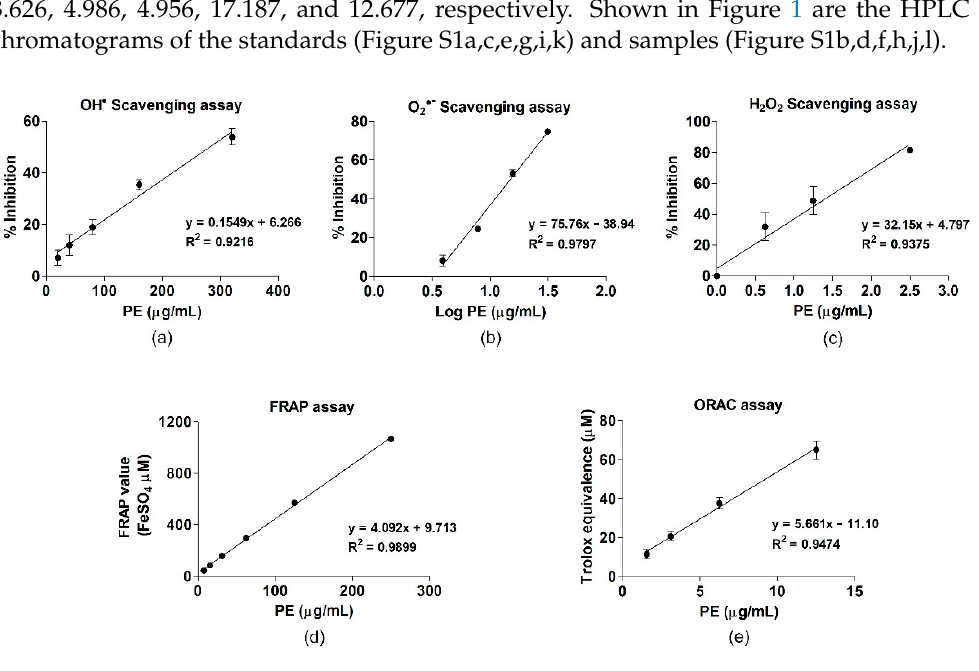
Figure 1. The linear regression of specific reactive oxygen species (ROS)-scavenging activities and antioxidant capacities of PE. ( a ) OH • , ( b ) O 2• − , and ( c ) H 2 O 2 scavenging activities. Antioxidant activities according to ( d ) FRAP and ( e ) ORAC. Table 1. The antioxidant activities and antioxidant capacities of PE.